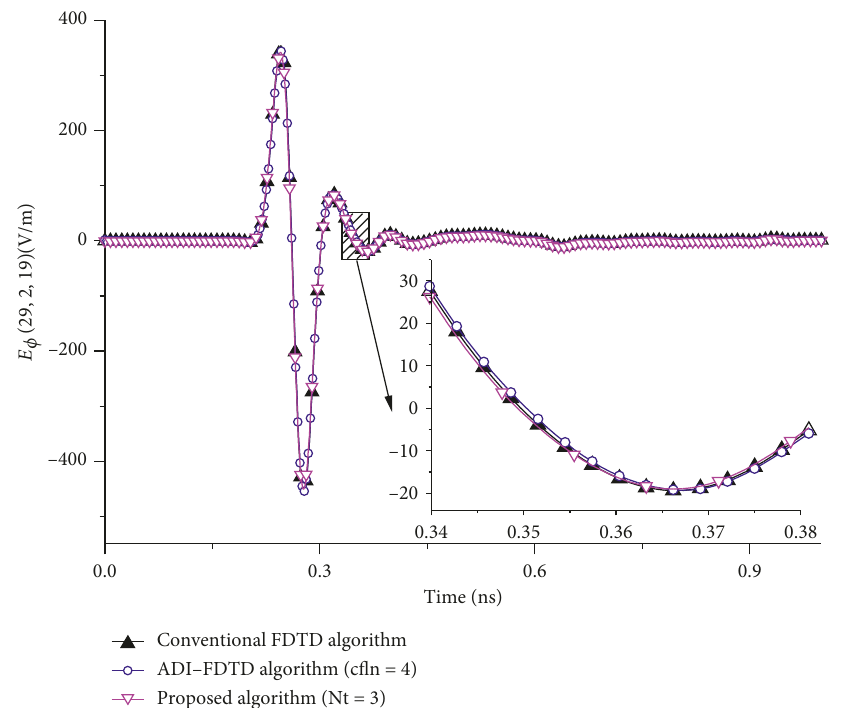
Figure 6: Computational results of E algorithm.